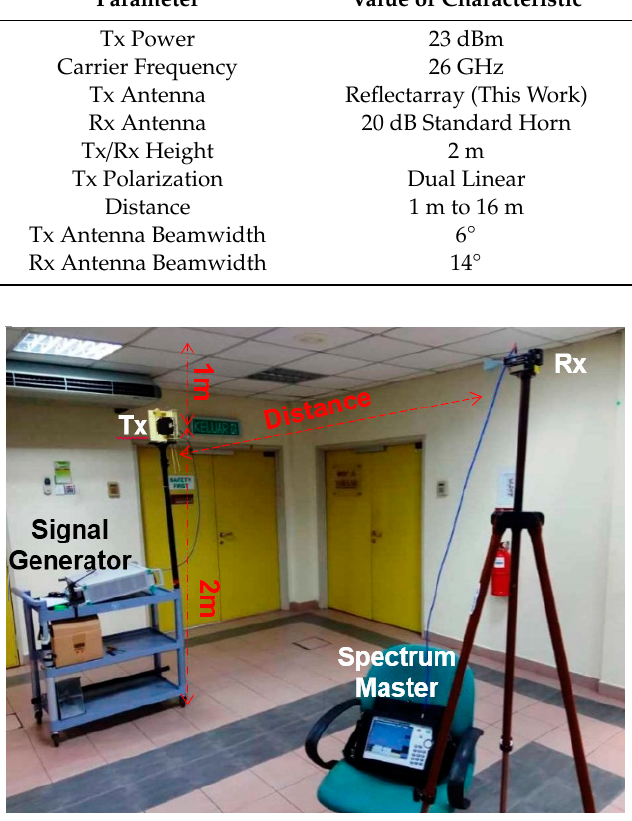
Figure 12. Indoor RSS measurement setup for asymmetric patch reflectarray antenna.